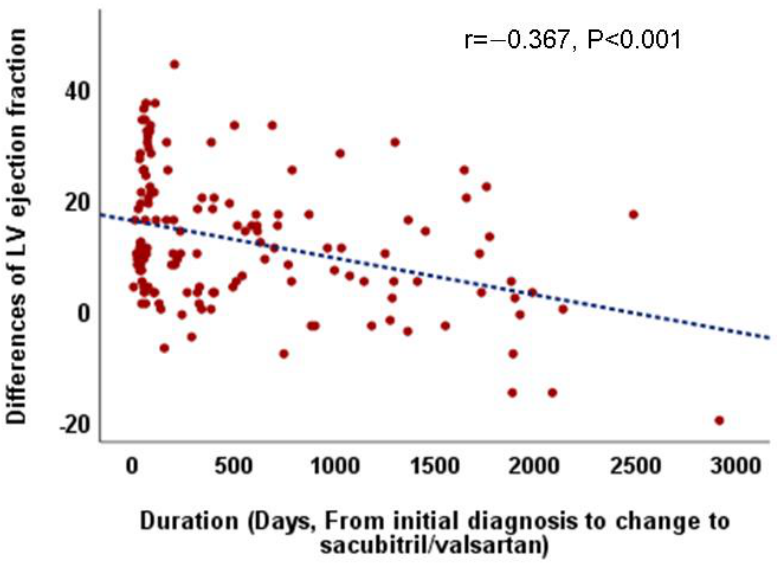
Figure 2. Correlation between the duration from the initial diagnosis to the change to sacubi- tril/valsartan and echocardiographic parameters especially left ventricular ejection fraction.